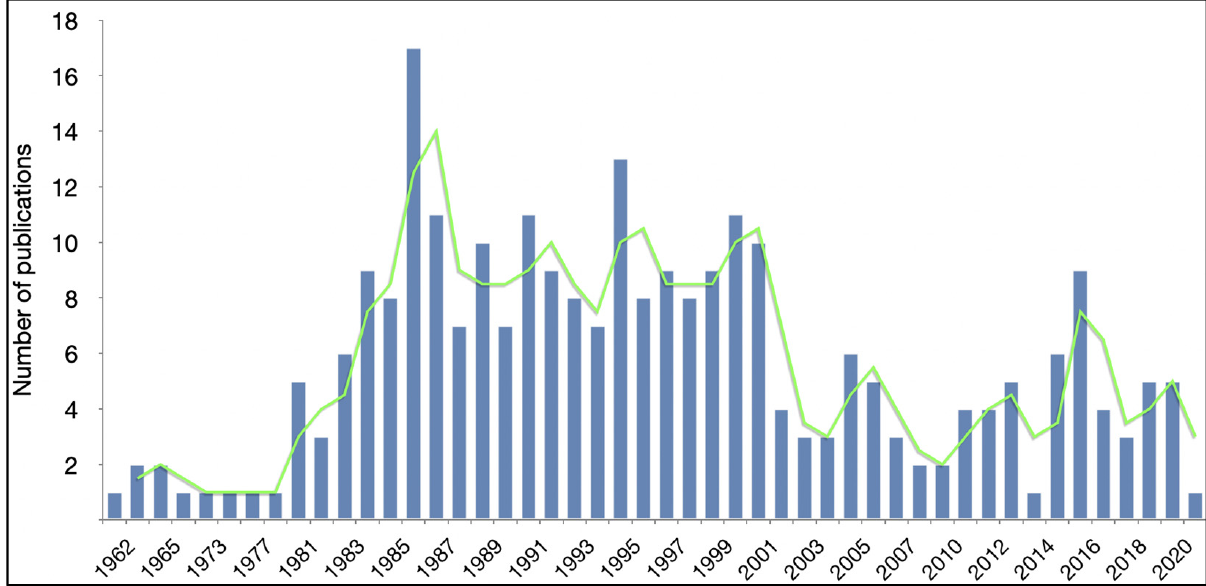
Figure 3. Distribution of articles about intra-arterial drug delivery for the treatment of brain tumors based on the year of publication.